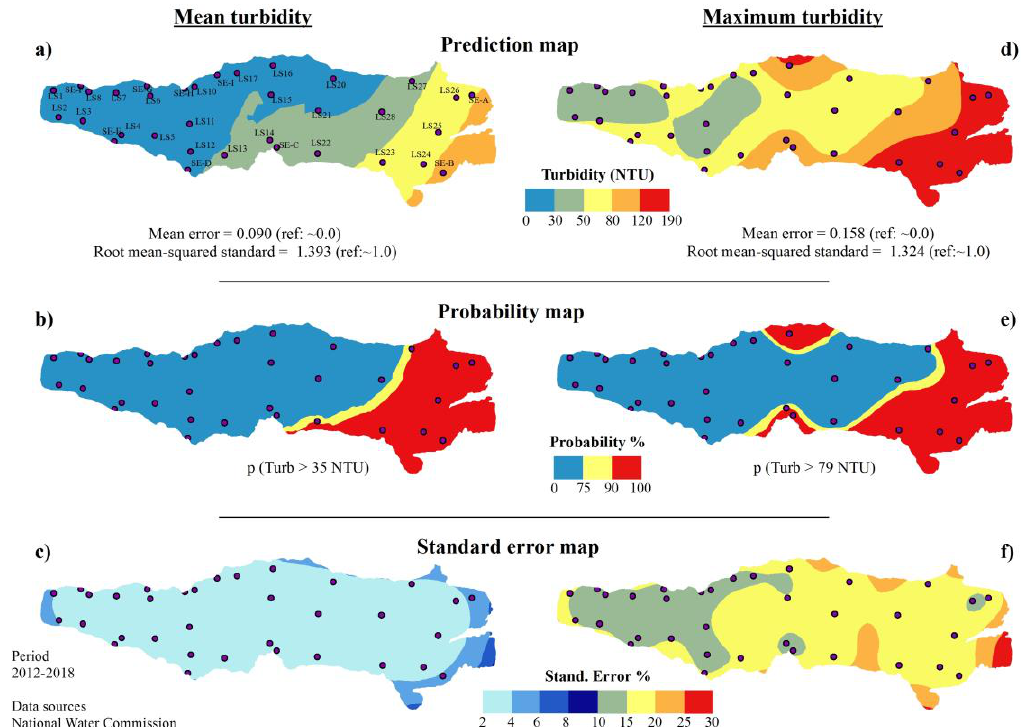
Figure 4. Geostatistical analysis of the turbidity in Lake Chapala. Concerning to the mean turbidity quantifications: ( a ) Prediction map, ( b ) Probability to overcome the average values, and ( c ) Spatial distribution of the standard error. Concerning to the turbidity quantifications: ( d ) Prediction map, ( e ) Probability to overcome the average values, and ( f ) Spatial distribution of the standard error.